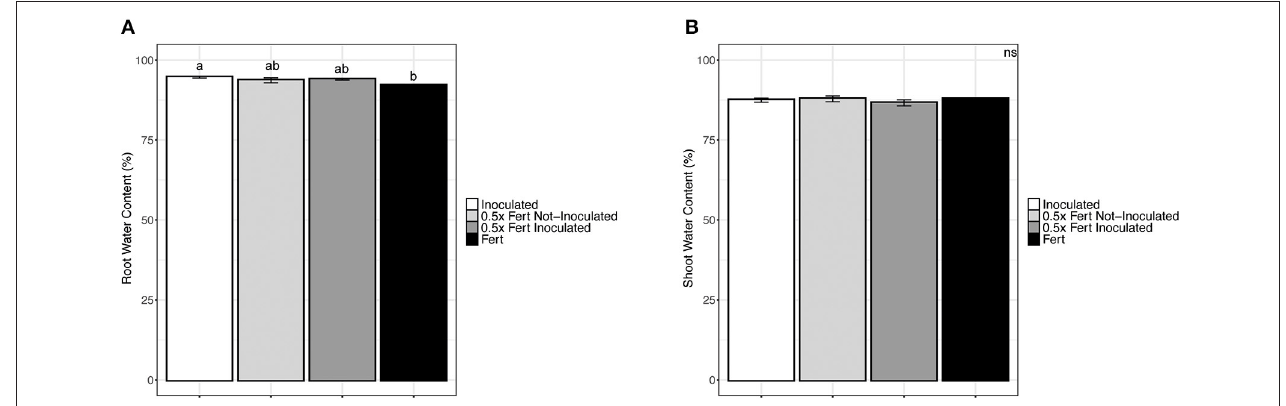
FIGURE 1 | Water content in cucumber plants. (A) Water content in roots of cucumber plants harvested after 60 days of cultivation in greenhouse and subjected to the different fertilization treatments (i.e., Inoculated, 0.5x Fert Not-Inoculated, 0.5x Fert Inoculated, and Fert). (B) Water content in shoots of cucumber